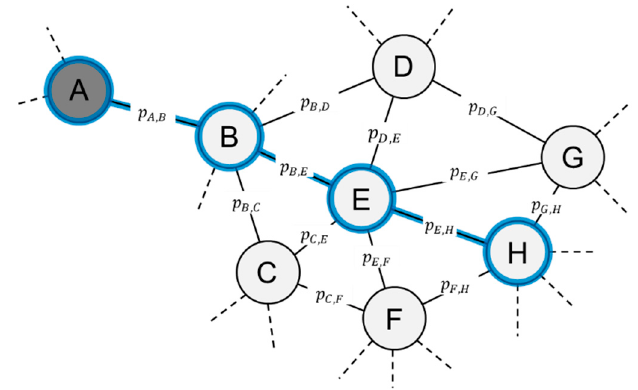
Figure A3. Example of research path in a subset of the technology space